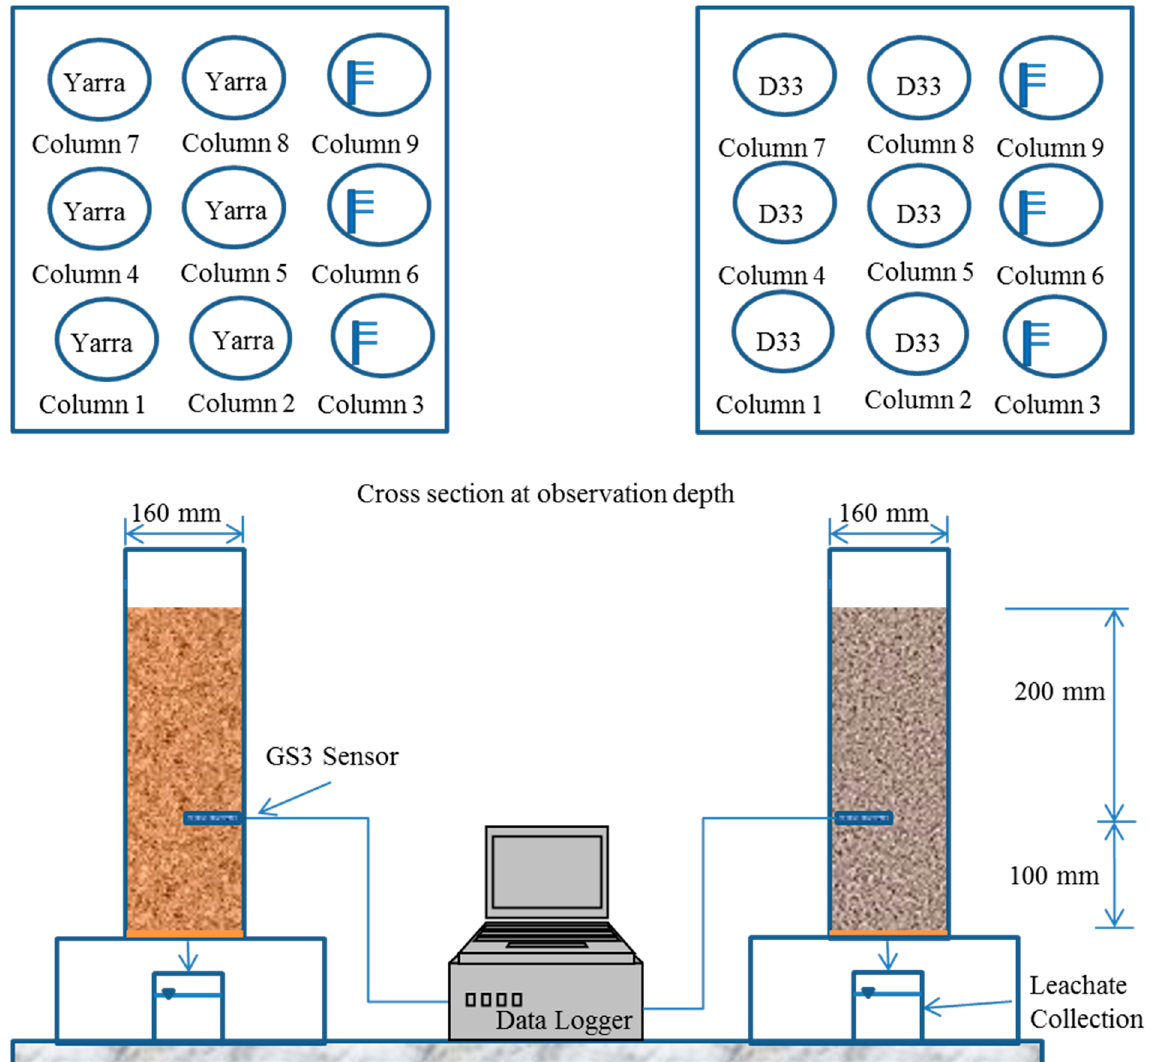
Figure 2. Schematic of the column set up to monitor the impact of irrigation water type on the salt accumulation in D33 and Yarramundi soil profile.